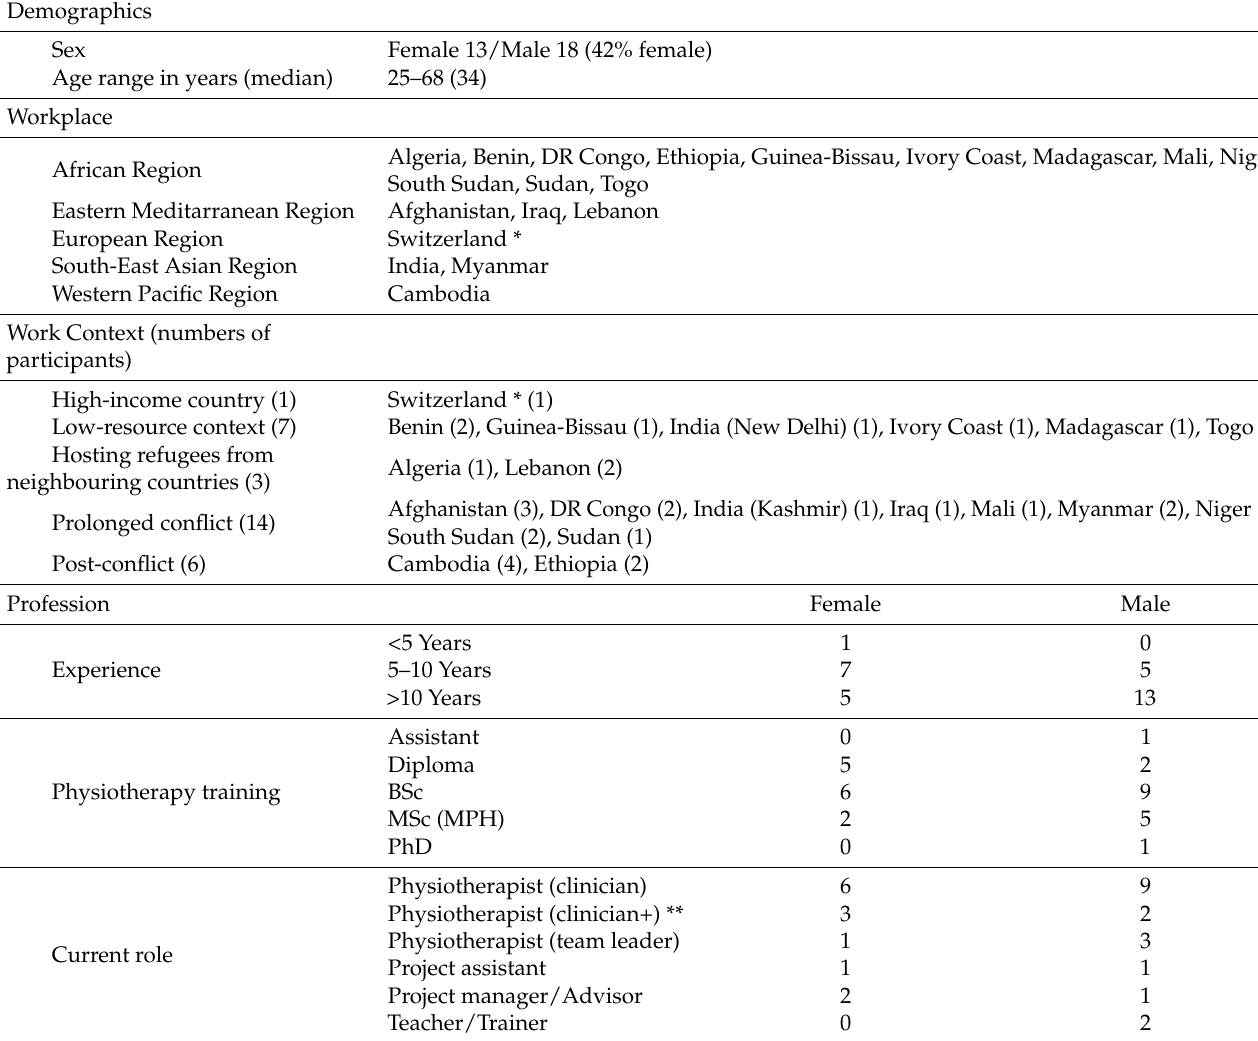
Table 1. Participant